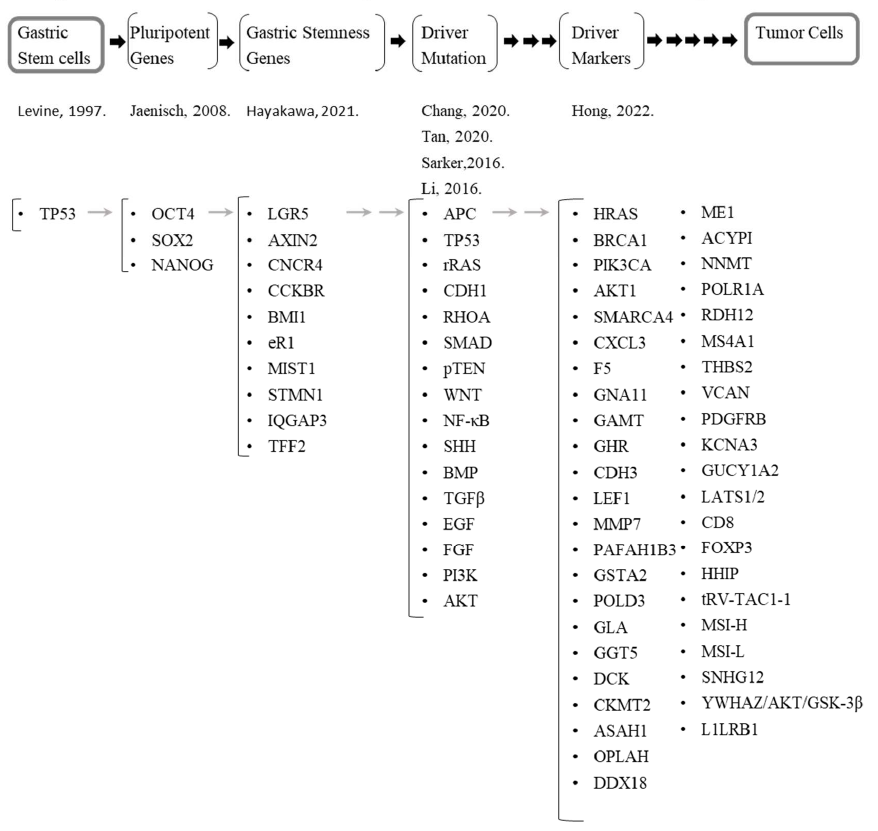
Figure 4. A possible road map to seek for the biomarkers for developing of human gastric cancer. The lineage of alterations of gastric stem cells are summarized for each step of mutations and epigenetic alterations of cancer-competent genes. Gastric stem cells cited as [87]; Pluripotent genes are cited as [87]; Driver mutations are cited as [32,41,60,61]; Driver markers have been cited recently in [7]. ACYP1: Acylphosphatase 1; ASAH1: N-Acylsphingosine amidohydrolase 1; BRCA1: